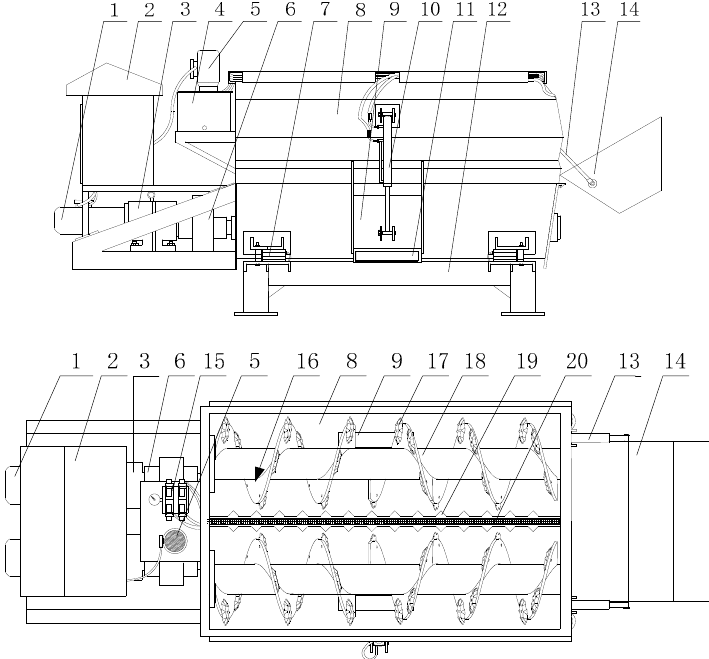
Figure 1. Schematic diagram of horizontal two ‐ axis TMR mixer mechanism.